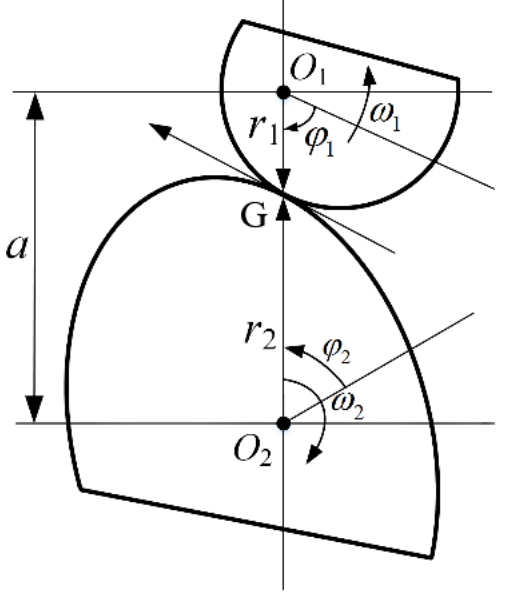
Figure 6. Schematic diagram of noncircular gear external meshing transmission.